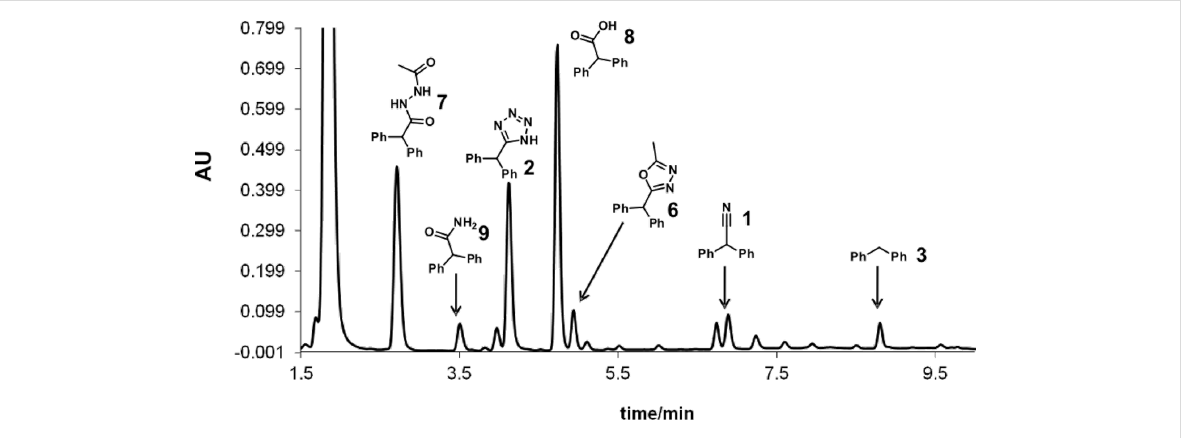
Figure 2: HPLC-UV chromatogram (215 nm) showing the decomposition of tetrazole 2 in NMP/AcOH/H 2 O 5:3:2 (0.125 M) after heating in a stainless steel flow coil at 180 °C for 5.3 min.